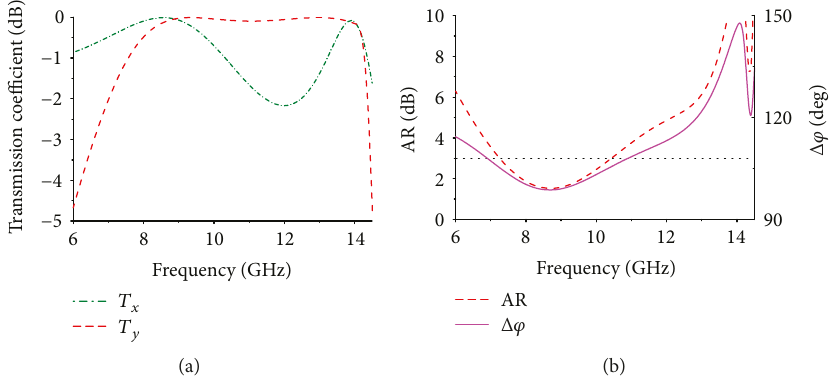
Figure 8: Simulated results of the polarizer with four the same layers.